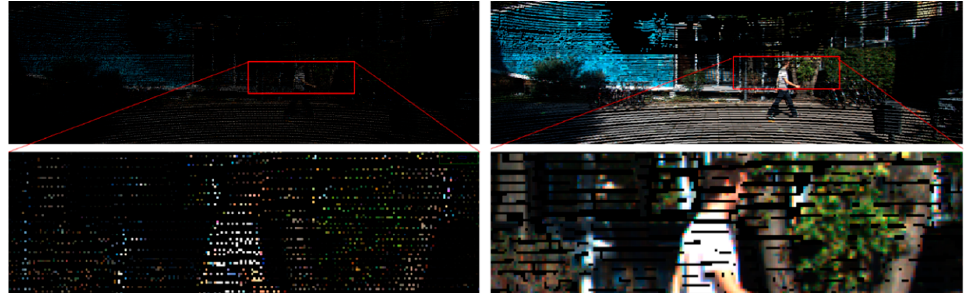
Figure 2. A visual representation of the pixel information utilization by PMPF. The left panel shows K = 1 and the right panel shows K = 3. In the left panel, the pixel information is sparse, while in the right panel the utilization is improved, and the pixel information is denser. The image and point clouds data are derived from the KITTI 3D dataset.